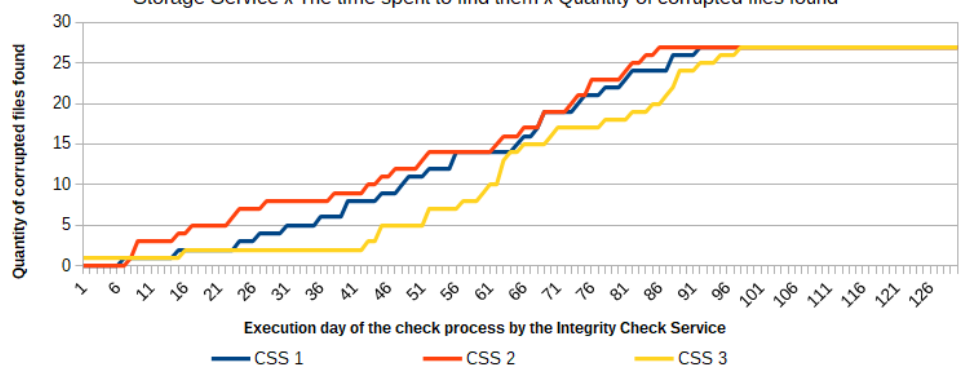
Figure 8. Comparison of the periods required to identify corrupted files in each of the